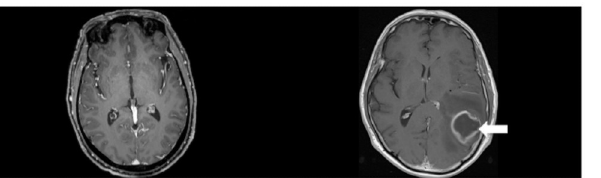
Fig 1. Exemplary stimuli used in our study, showing T1-weighted post-contrast MR images of a normal (left image) and a pathologic (right image) brain. The arrow indicates a glioblastoma. Note, the arrow was not shown to